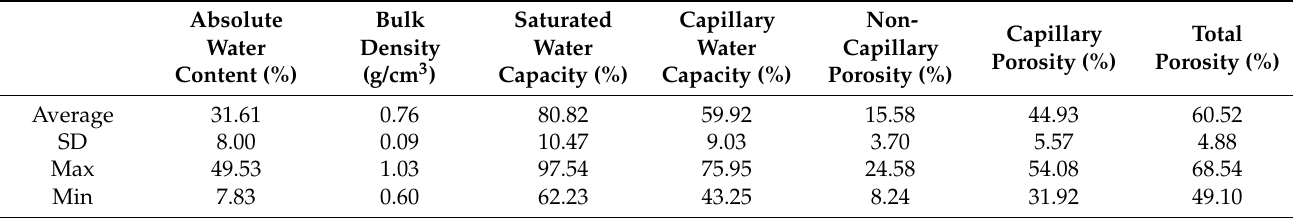
Table 1. Soil physical properties in the study area.